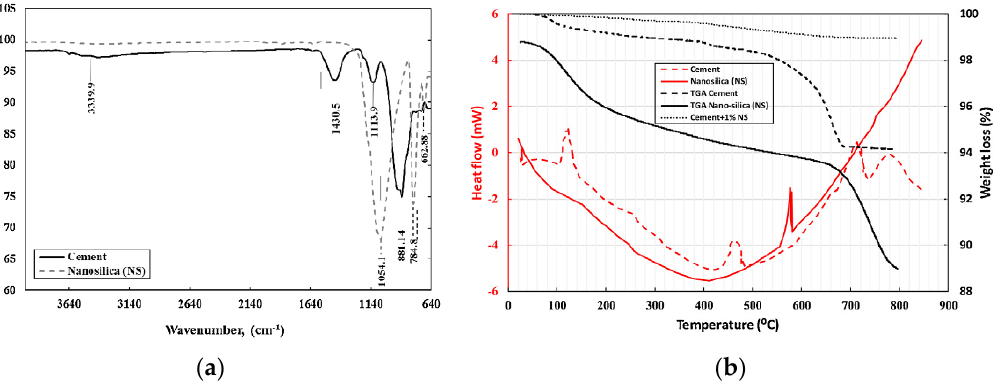
Figure 6. XRD spectra of ( a ) control sample and ( b ) NS sample concrete [60].